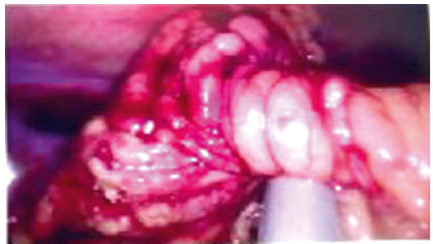
Figure 3: Torted omentum with a clockwise